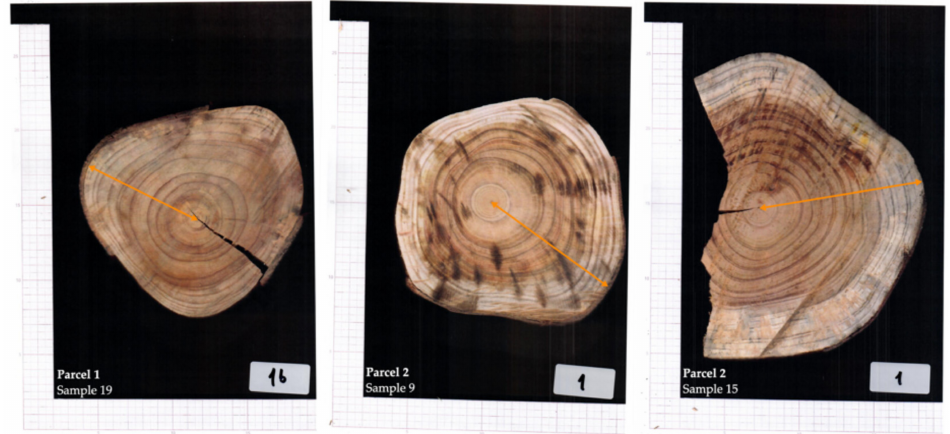
Figure 10. Slices used in the age determination of the specimens by counting the growth